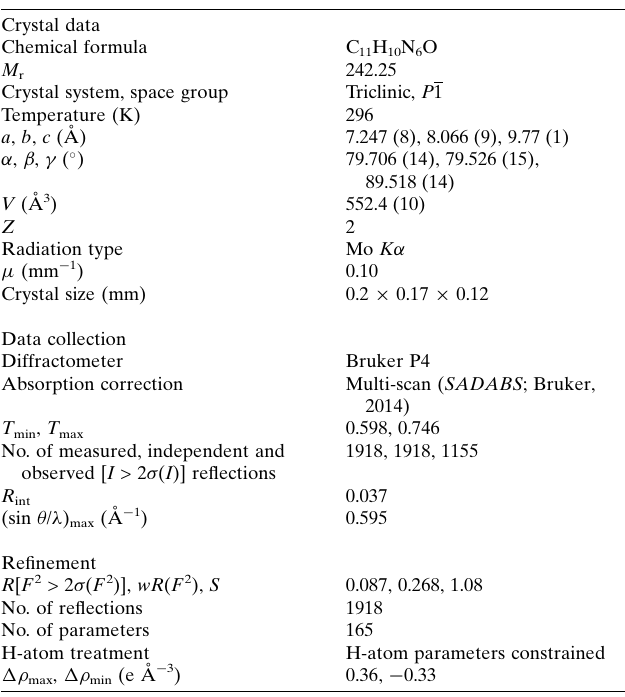
Table 2 Experimental details. Crystal data Chemical formula